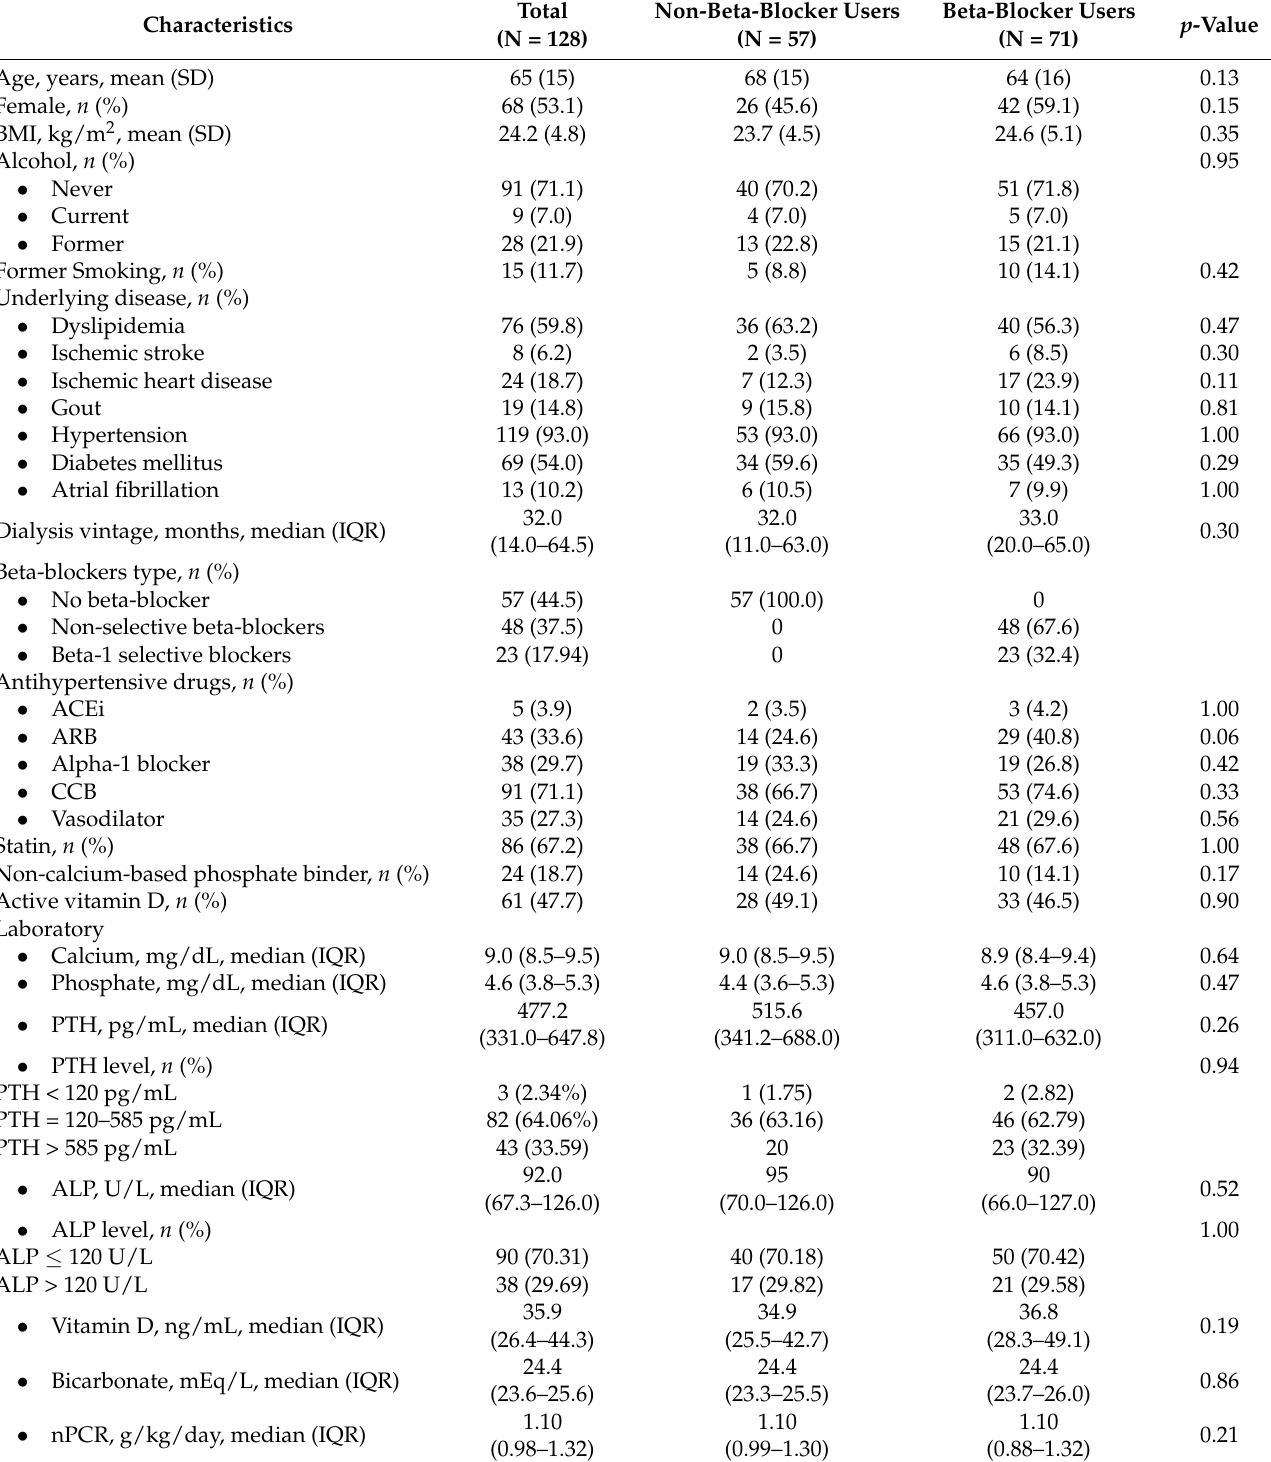
Table 1. Baseline characteristics of